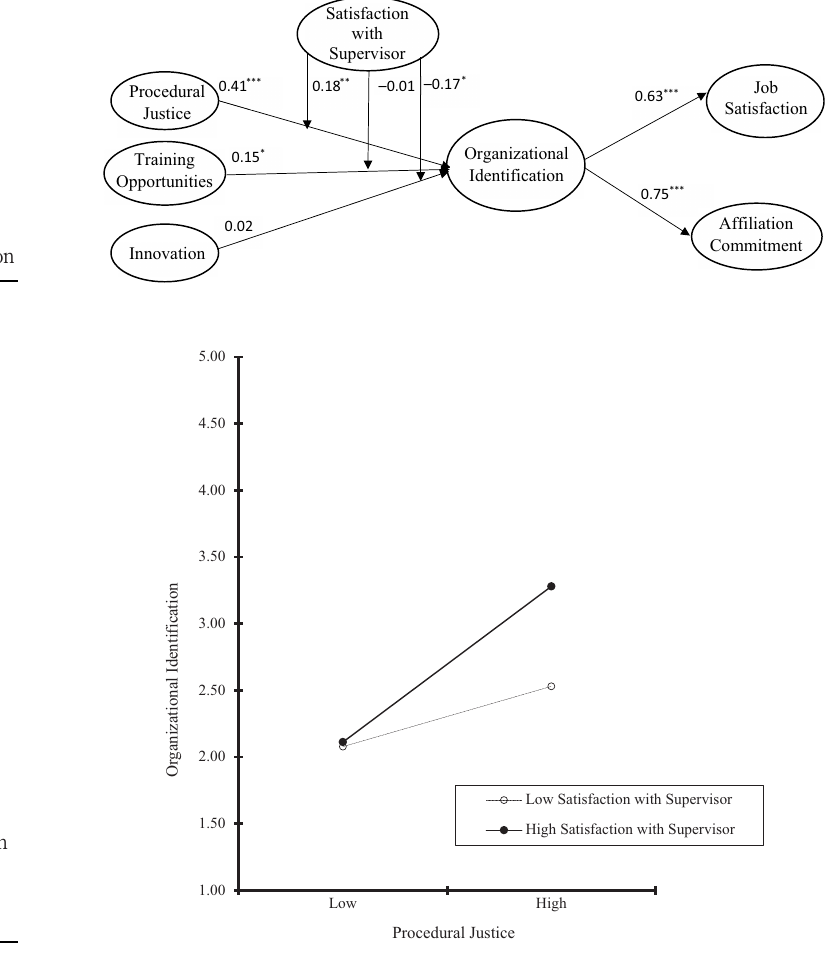
Figure 3. Interactive effect of satisfaction with supervisor on the relationship between procedural